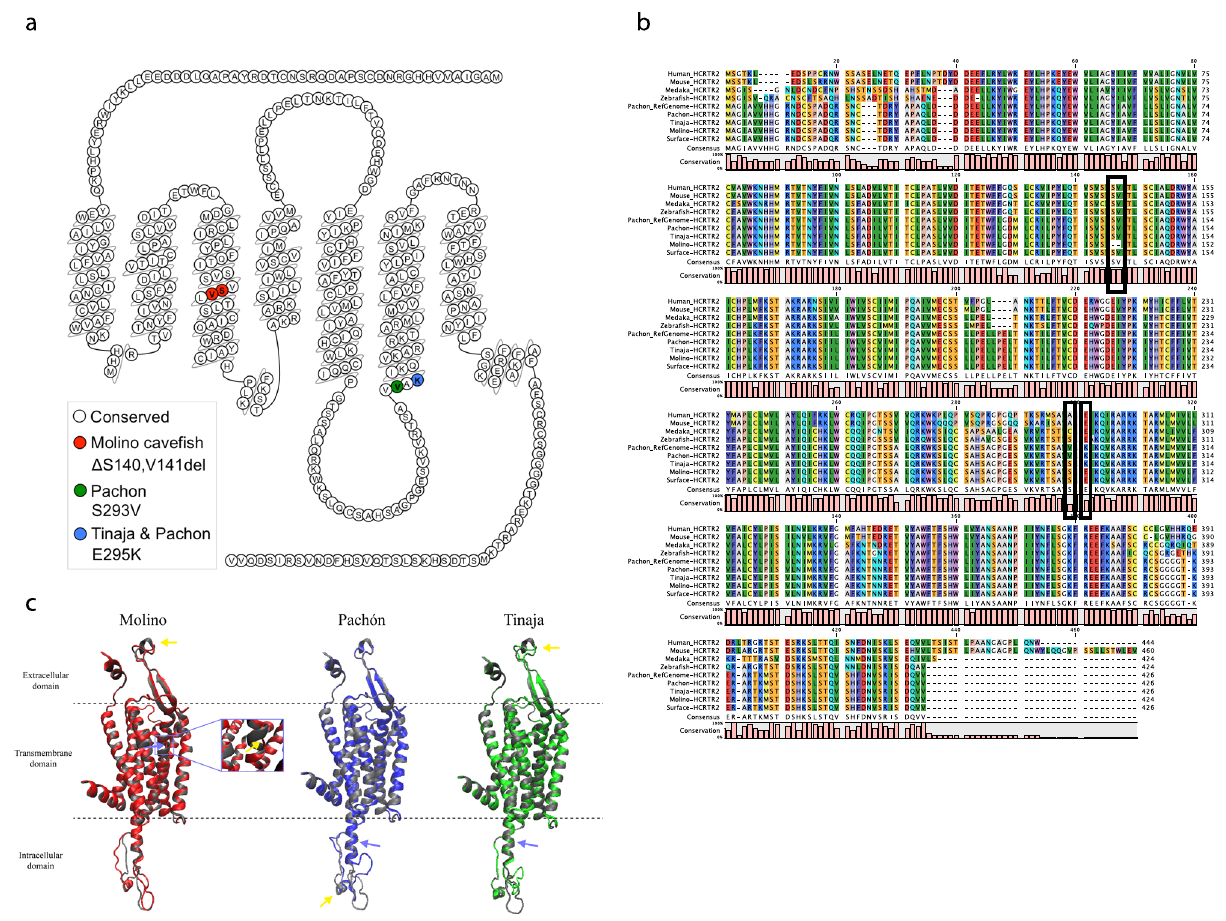
Fig. 5 Hcrtr2 mutations in cave fi sh. a Position of mutations in hcrtr2 in the different cave fi sh populations. b Sequence alignment showing that the mutations in Molino and Tinaja are affecting evolutionary conserved amino acids. c 3D model based on structure of human HCRTR2. Structure is displayed as comic structure displaying alpha helices and beta sheets using VMD 1.9.3. A model of Hcrtr2 from surface and cave fi sh fi sh was rendered using SWISS- MODEL (https://swissmodel.expasy.org/) and X-ray crystal data from RCSB Protein Data Bank: 5wqc. Purple arrows indicate site of mutation and yellow arrows indicate sites with differences in the secondary structure between surface and respective cave fi sh. In the Molino projection, the deletion (S140 and V141) in the Molino sequence causes a break in one of the alpha helix structures of the transmembrane domain (highlighted in purple box). These images were made with VMD 89 software support. VMD is developed with NIH support by the Theoretical and Computational Biophysics group at the Beckman Institute, University of Illinois at